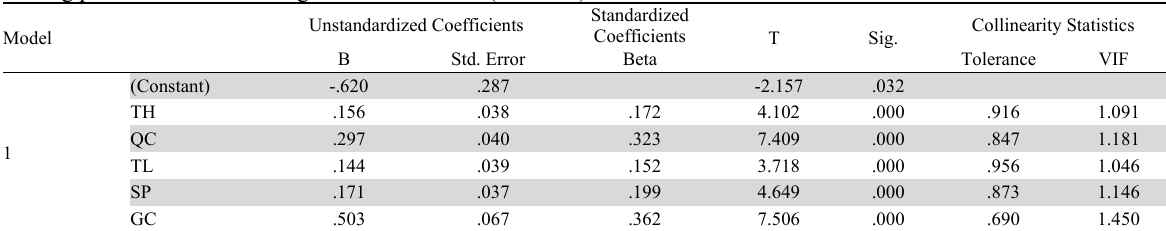
Unstandardized Coefficients Standardized